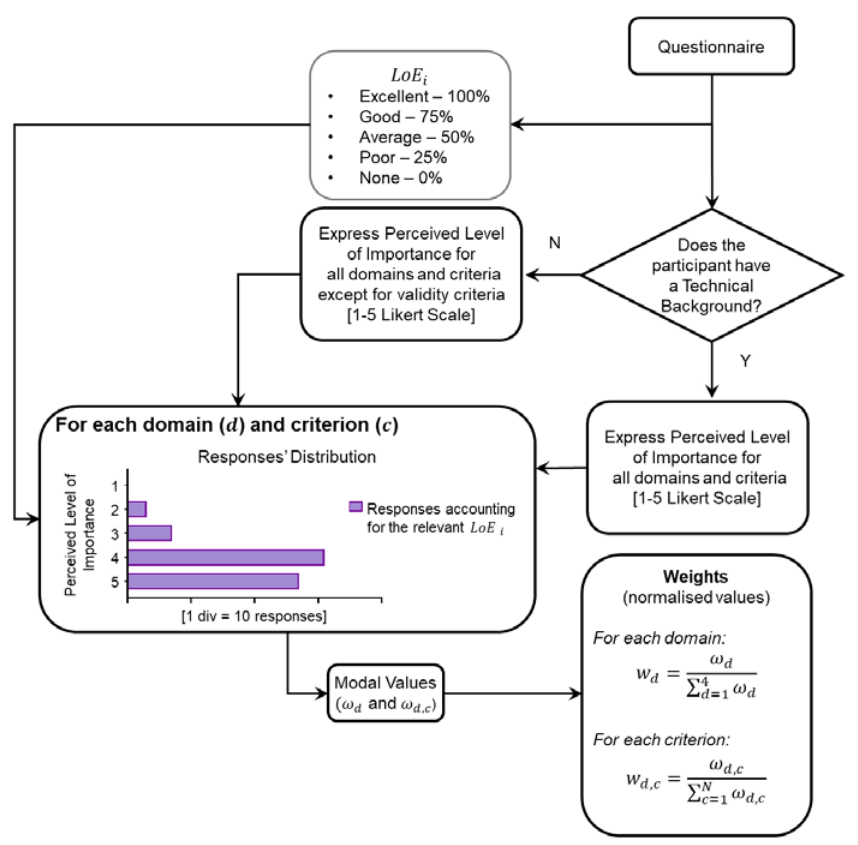
Figure 3. Process figure showing how the gathered responses about the perceived level of importance of the di ff erent domains and criteria are used to identify the normalized weights for each domain ( d ) and criterion ( c ).